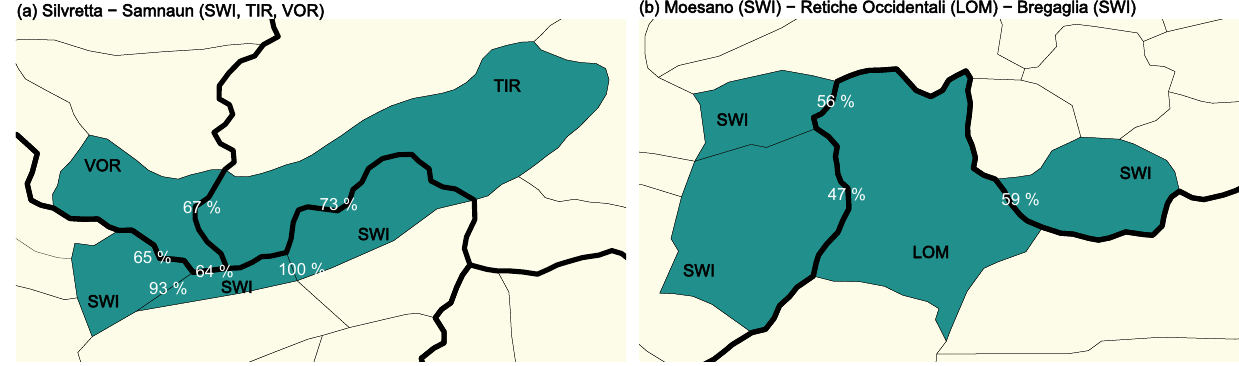
Figure 8. Example regions: (a) Silvretta mountain range with the Silvretta warning regions in Vorarlberg (VOR) and Tirol (TIR) and three Swiss warning regions (SWI, from west to east: western Silvretta, eastern Silvretta, and Samnaun). (b) the Alpi Retiche occidentale warning region (forecast center Lombardia (LOM)) and the three Swiss warning regions Alto Moesano, Basso Moesano, and Bregaglia. Here, the main Alpine divide runs right to the north of the dark-colored regions. The percentage values show the agreement rate between warning regions ( D max ). The maps show an area of 83 by 45km. The location of these two example regions in the Alps is marked in Fig.